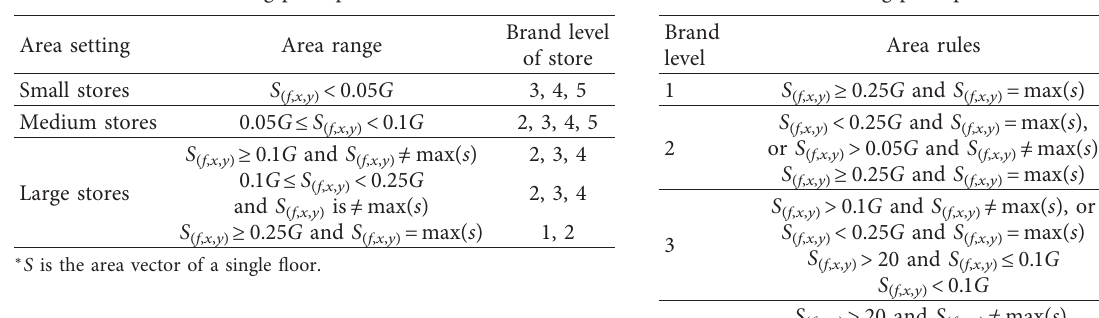
Table 3: Matching principle of area and level. Table 4: Matching principle of level and retail